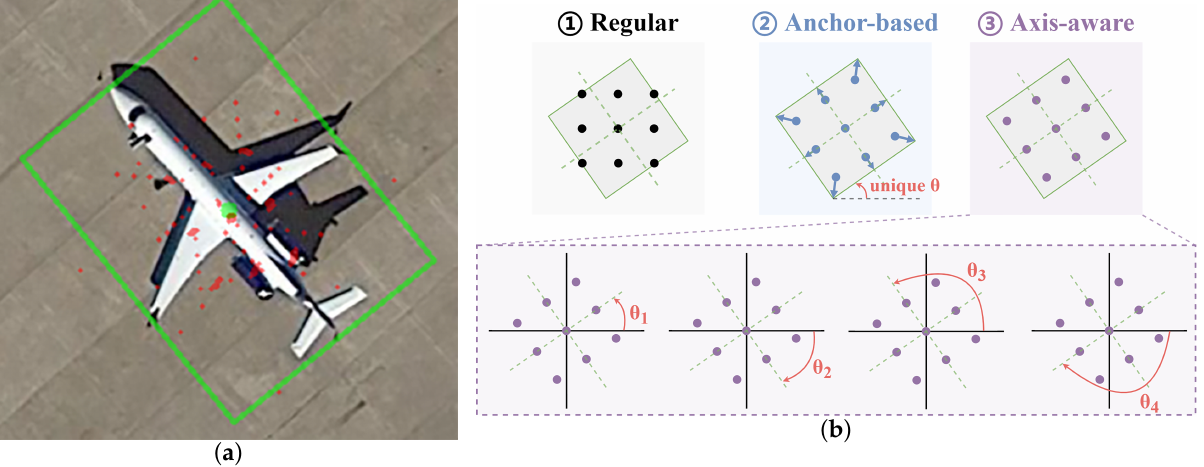
Figure 4. ( a ) The green box is the ground truth, and the green point is its center point. The red point is the sampling position guided by the anchor on the pyramid features from P3 to P6 based on the green point. It can be seen that most of the sample points are offset to the background under the guidance of the anchor box. ( b ) Sampling axis representation under three sampling methods. The regular sampling method cannot align the axis of remote-sensing targets, and the anchor-aware sampling axis is represented by a unique angle. Our axially aware sampling can represent an axis in four